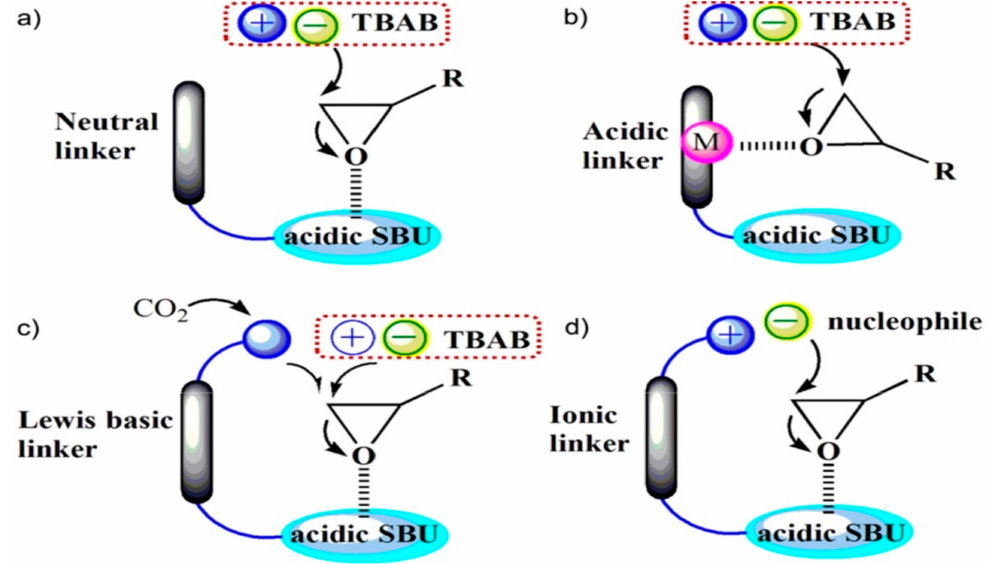
Figure 5. Epoxide activation modes by different MOF catalysts. ( a ) MOFs with acidic SBUs, ( b ) MOFs with acidic linkers, ( c ) MOFs with Lewis base linkers, ( d ) MOFs with ionic linkers. Reprinted with permission from Ref. [102]. Copyright 2019